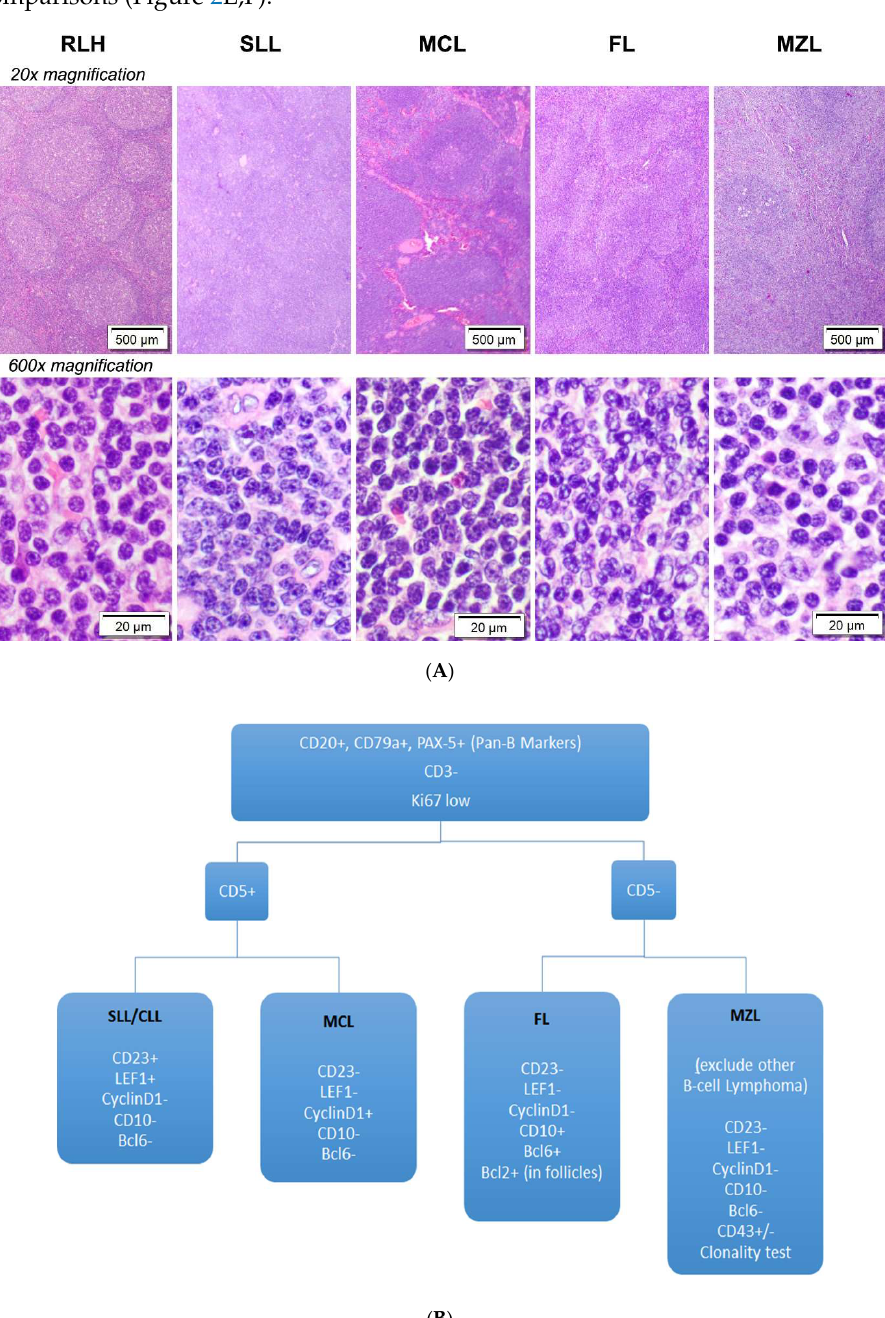
Figure 1. Challenges in diagnosing small B-cell lymphoma. ( A ) The morphologic overlap between reactive lymphoid hyperplasia and the four histological subtypes of small B-cell lymphomas (SLL, MCL, FL and MZL) presents considerable challenge to traditional morphological diagnosis and subtyping. Classification of lymphoma from reactive lymphoid hyperplasia often relies heavily on ancillary techniques such as immunohistochemistry. ( B ) A wide panel of immunohistochemical stains is often used by pathologists to diagnose and subtype small B-cell lymphomas. Abbreviations: RLH, reactive lymphoid hyperplasia; SLL, small lymphocytic lymphoma/chronic lymphocytic leukemia; CLL, chronic lymphocytic leukemia; MCL, mantle cell lymphoma; FL, low-grade follicular lymphoma; MZL, marginal zone